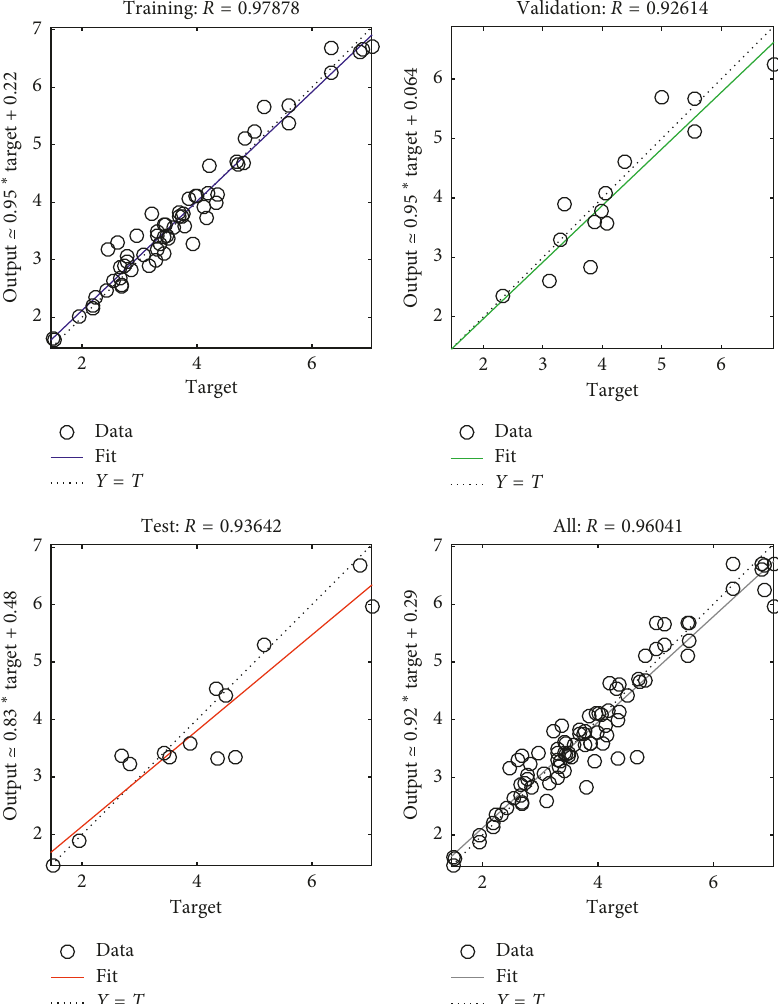
Figure 11: Training, validation, testing phases, and all data for the Marshall quotient (kN/mm) ANN